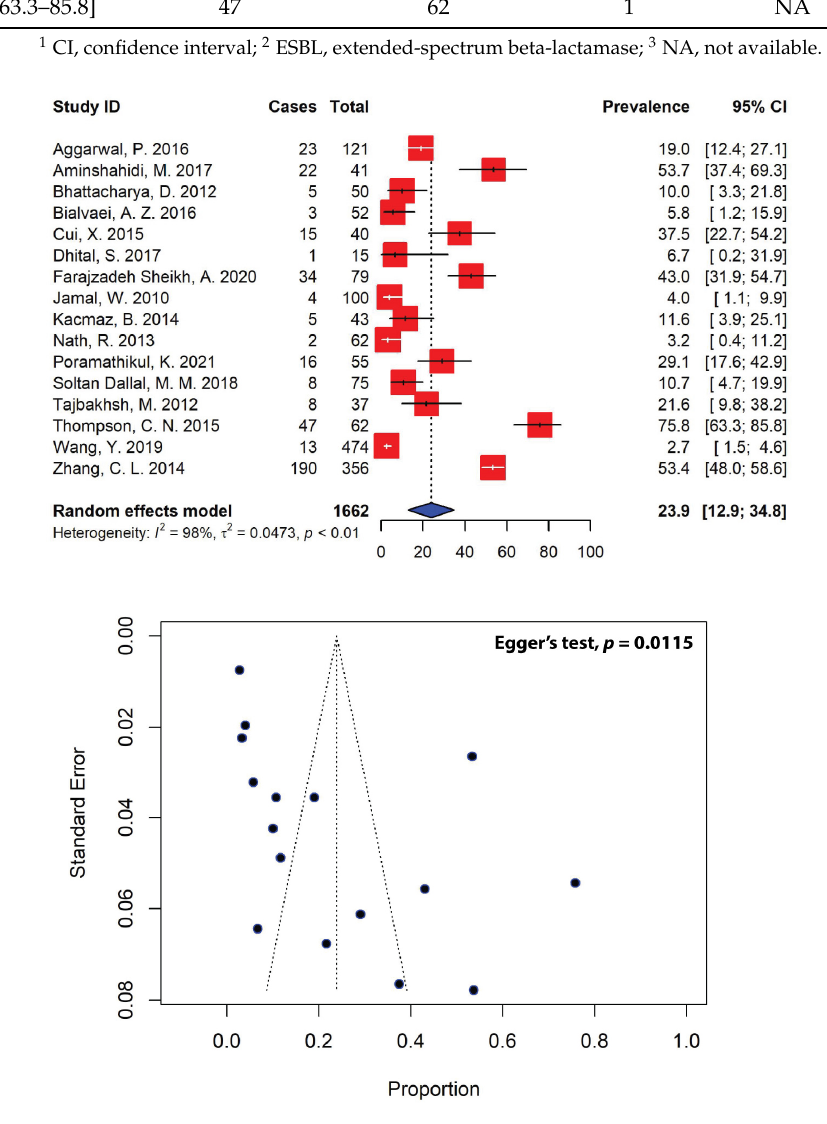
Figure 6. Forest and funnel plots representing the pooled prevalence of extended-spectrum β -lactamase (ESBL)-producing Shigella spp. in Asia. The estimate of prevalence was calculated by pooling 16 studies using the random-effects model ( top panel ). The distribution of effect estimates is shown by a funnel plot ( bottom panel ). Figures were generated using RStudio software.